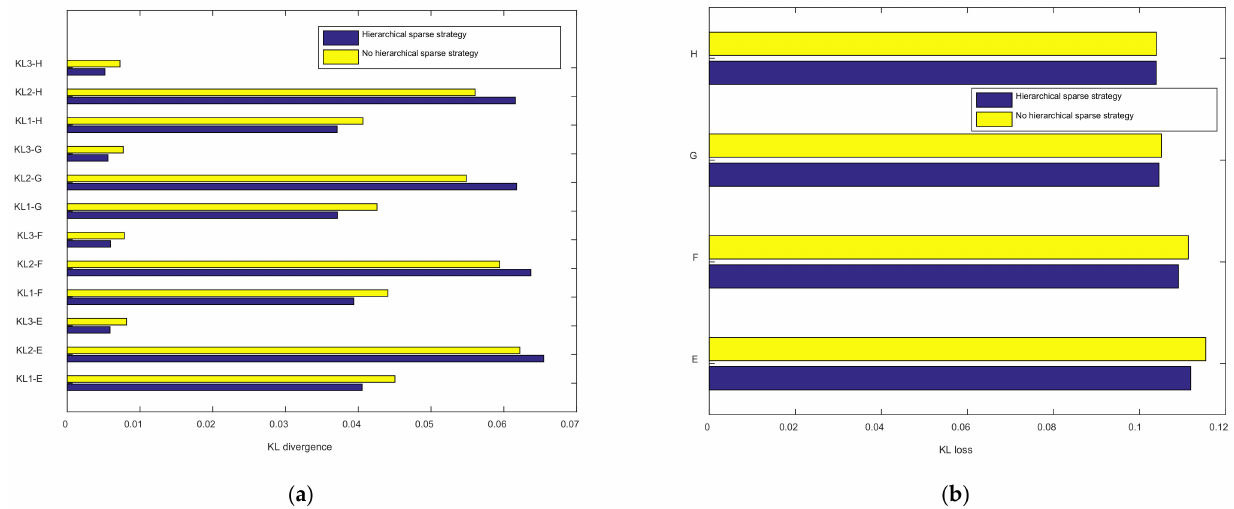
Figure 13. The effect of hierarchical sparsity strategy on network sparsity. ( a ) KL divergence of neurons in each layer of different data sets; ( b ) KL divergence total loss for different data